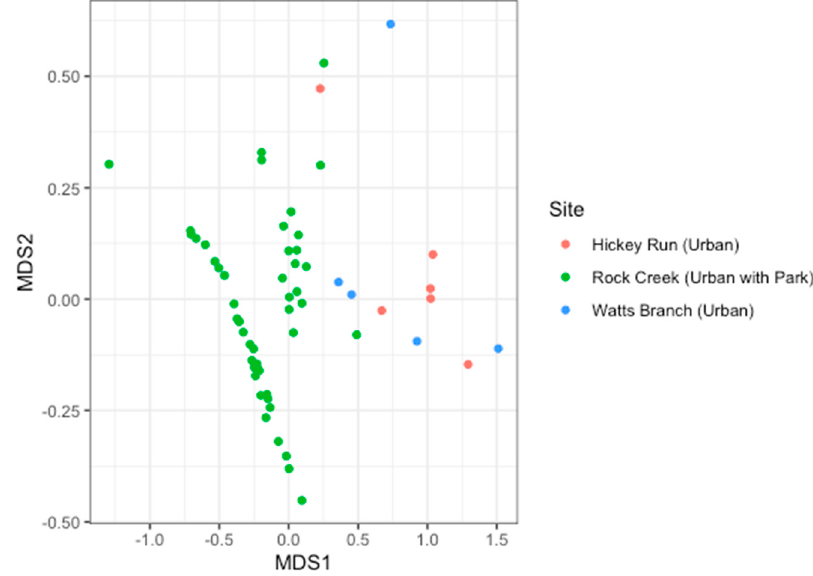
Figure 4. Non metric multidimensional scaling plot for Rock Creek, Hickey Run and Watts Branch watersheds.